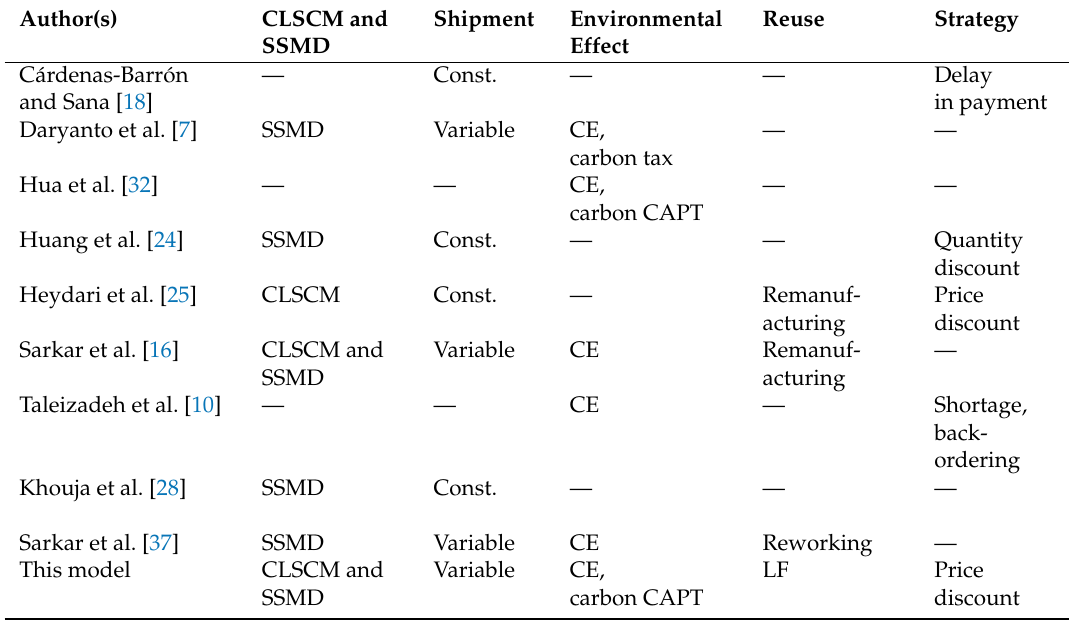
Table 1. Author(s) comparison